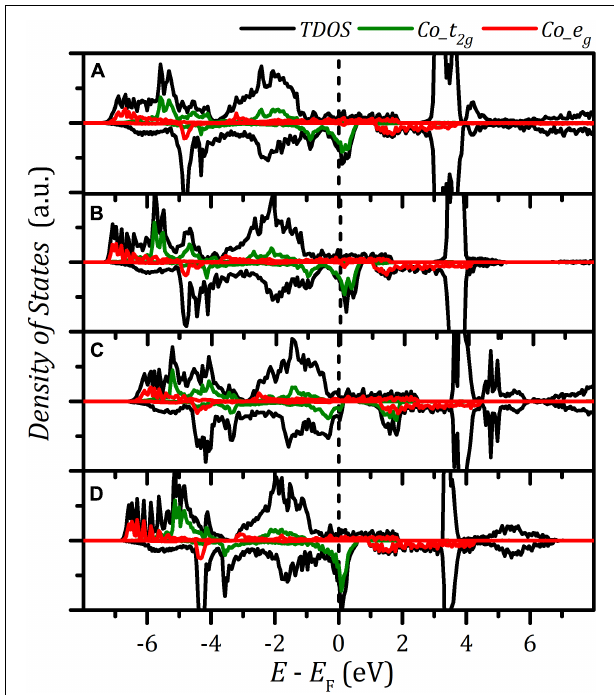
FIGURE 7 | Density of states: (A) Ba c , (B) Ba c + b , (C) Ba c + f1 + f3 , and (D) Ba c + f1 + f2 + f3